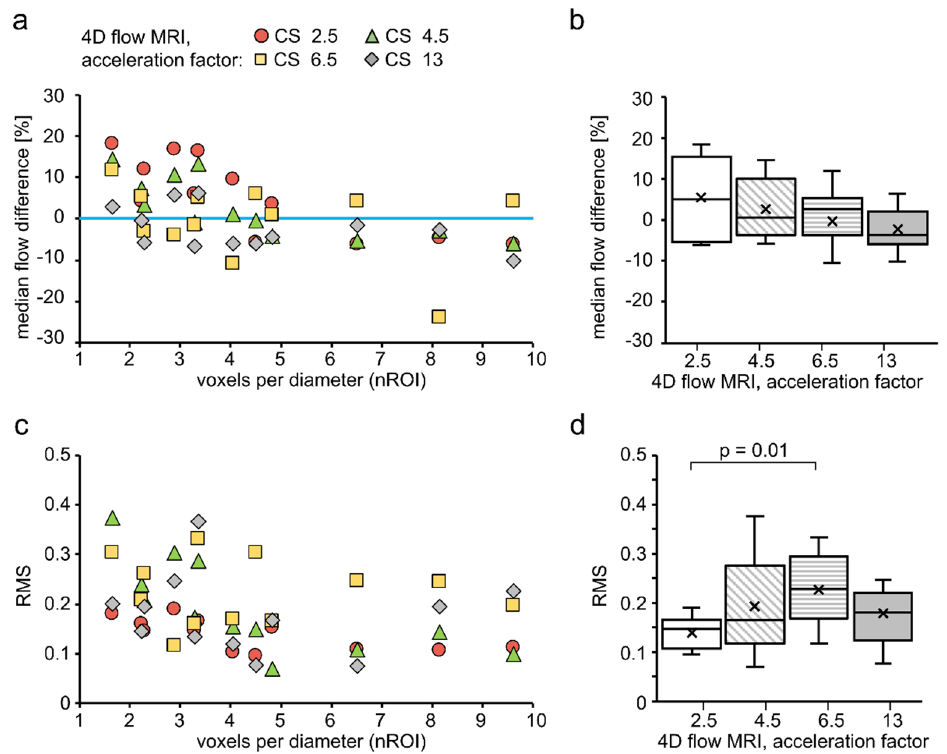
Figure 5. Scatter (left) and box plots (right) for experiments performed on silicone tubes. ( a ) The median difference between flow rate values measured with 4D and 2D flow tended to decrease with increasing voxel number per diameter. ( b ) Median flow difference tended to decrease with an increased CS factor. ( c ) RMS tended to decrease with increasing voxel number per diameter. ( d ) RMS tended to increase with increased CS factor from 2.5 to 6.5. RMS obtained with CS = 2.5 was significantly different from CS = 6.5. For creating box plots in ( b , d ), RMS and flow difference values, obtained by 4D flow MRI with various nROIs but with the same CS factor, were joined together to make one dataset. Therefore, the dependency of data on nROI was